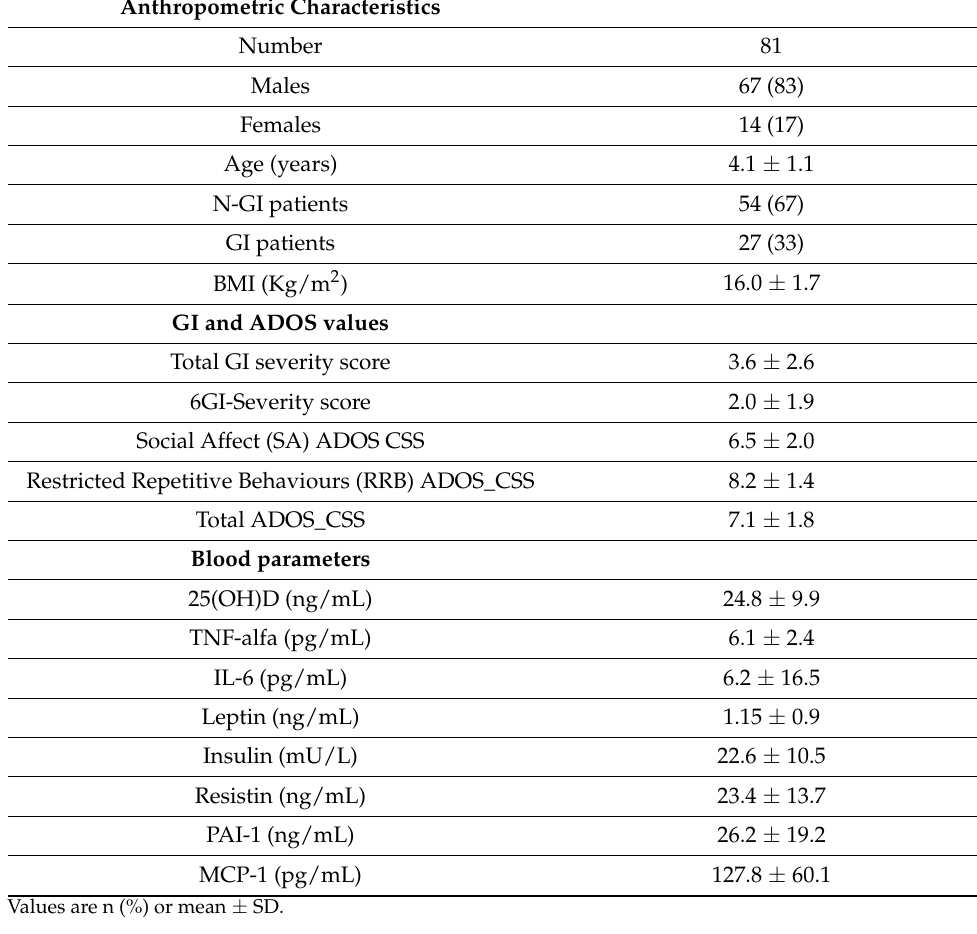
Table 1. Characteristics of the studied population.